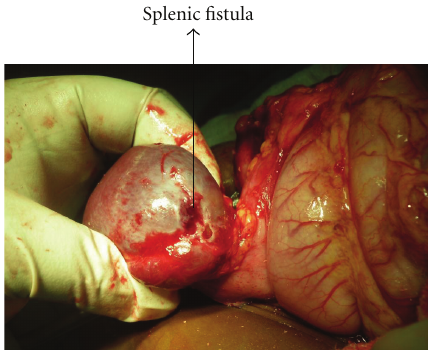
Figure 3: Splenic erosion and splenic fistula.